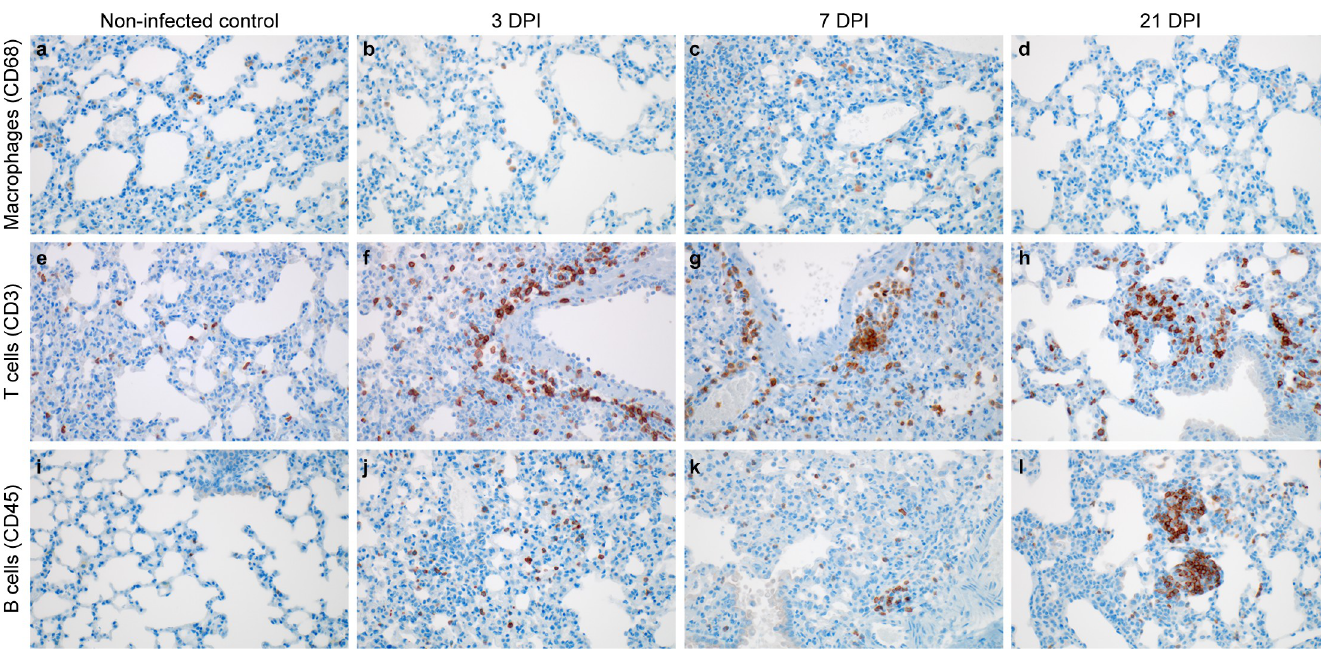
Fig 4. Infiltration of innate and adaptive immune-cell populations in the lungs of SARS-CoV-2 infected mice. a, e, i, non-infected control. b, f, j,105 TCID50 3 DPI. c, g, k, 105 TCID50 7 PDI d, h, l, survivor animal 21 DPI. a. γ -irradiated SARS-CoV-2 inoculated controls with few macrophages (brown). b, c. Increased macrophages at 3 and 7 DPI. d. Macrophages present at end of study. e. Scattered T cells (brown) in the γ -irradiated SARS-CoV-2 inoculated controls. f, g. T cells are increased in perivascular tissue and alveolar septa at 3 and 7 DPI. h. T cells forming lymphoid aggregates with B cells in perivascular tissues. i. B-cells (brown) are few in the γ - irradiated SARS-CoV-2 inoculated controls. j,k. B cells are increased in alveolar septa at 3 and 7 DPI. l. B cells forming lymphoid aggregates with T cells in perivascular tissues. Magnification: a-l = 400 x.